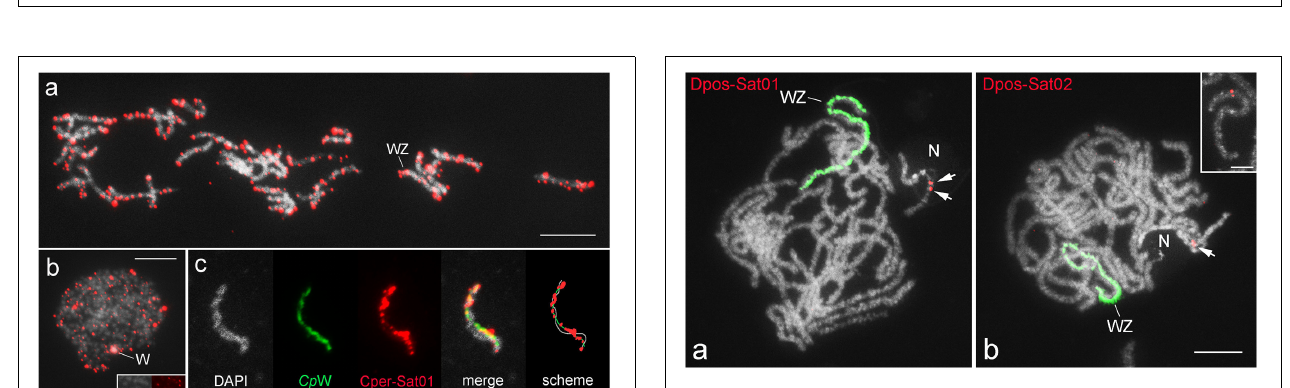
FIGURE 4 | SatDNA landscapes of male (blue) and female (red) repeats for each satDNA identified in (A) Cydalima perspectalis , (B) Diatraea postlineella , and (C) Ostrinia nubilalis .